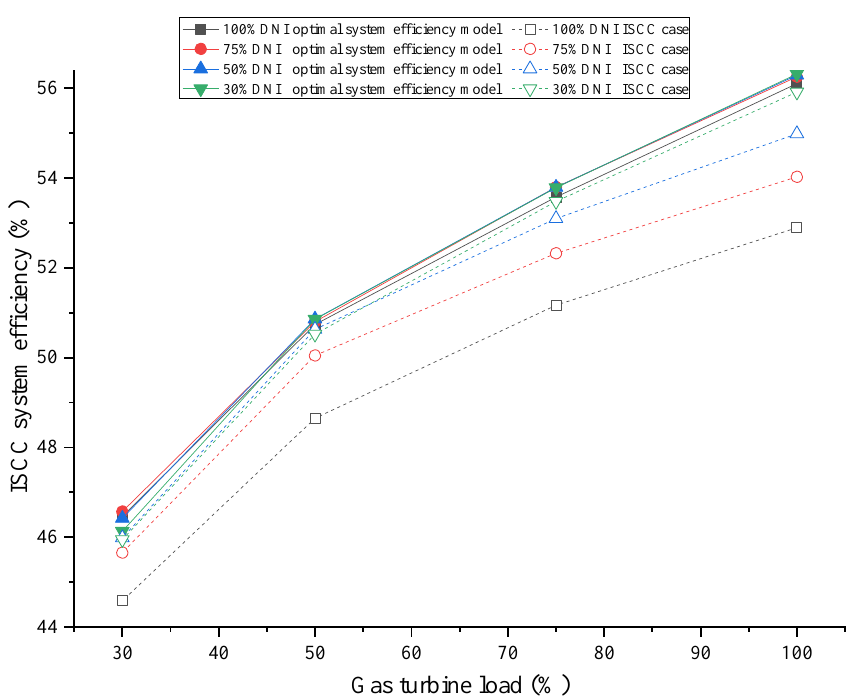
Figure 11. System efficiency of ISCC for the optimization model and comparison group from Zhang et al. [31].